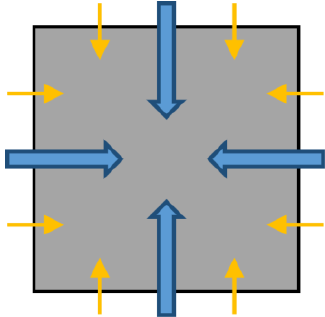
ff usion under bidisperse di ff usion (BD) Model Figure 2. Concepts of gas diffusion under bidisperse diffusion (BD) Model [24]. Figure 2. Concepts of gas di